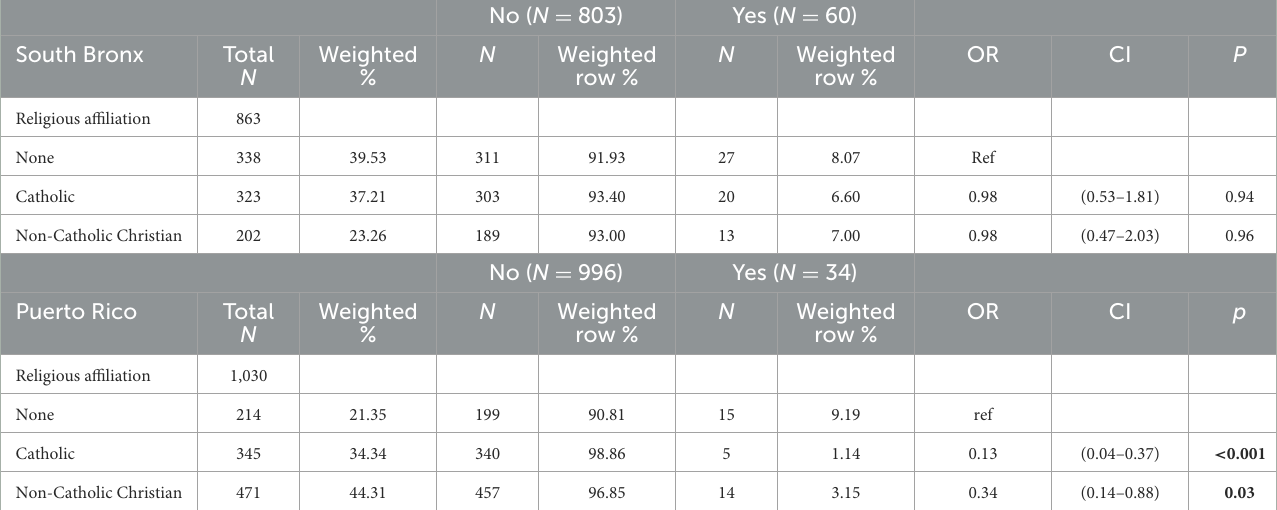
TABLE 4 Interaction of religious affiliation with site and illicit substance use disorder ∗